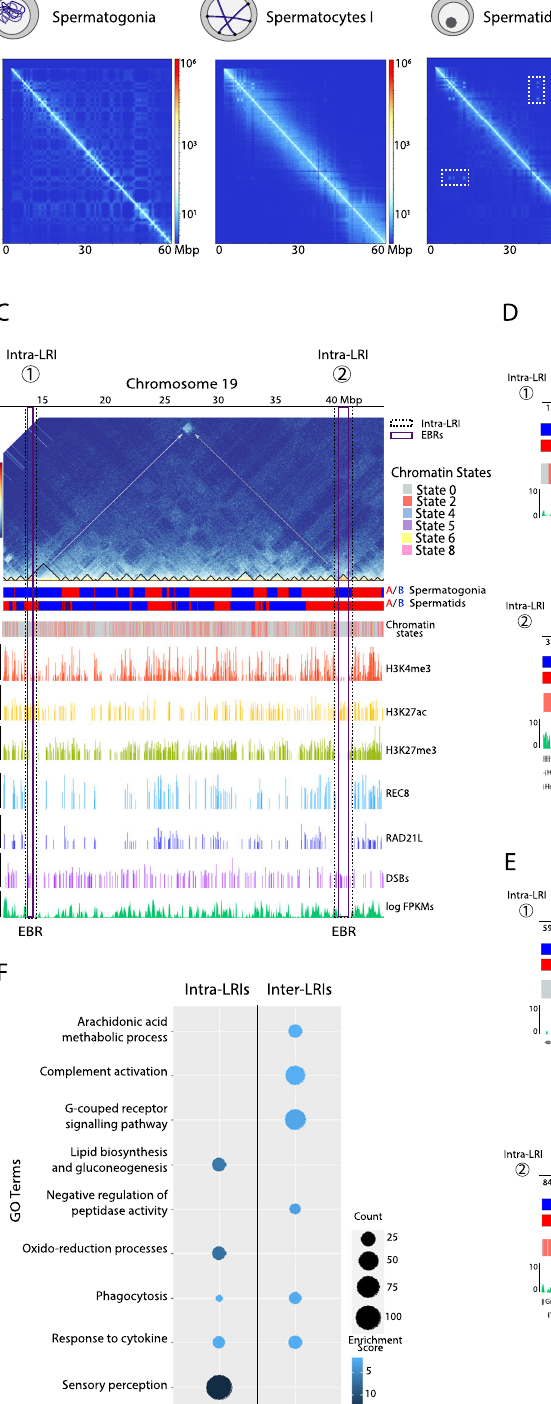
Our results highlight the importance of interpreting the dynamic spatial genome organisation of germ cells in the context of germline DNA damage responses (DDR) and meiotic checkpoints (Fig. 6). During gametogenesis, there are two key waves of DNA damage induction that may trigger genomic rearrangements: (i) pro- grammed meiotic DSBs catalysed by SPO11 in early stages of